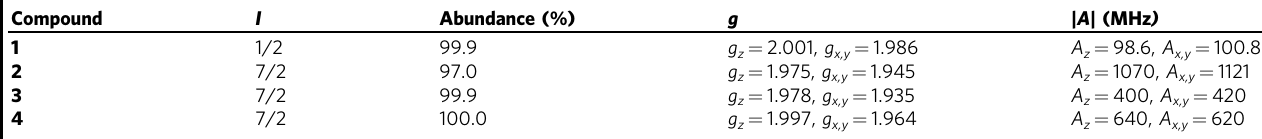
Table 1 Observed g -values and hyper fi ne coupling constants for 1 – 4 in frozen solution at X-band ( ca . 9.5 GHz)